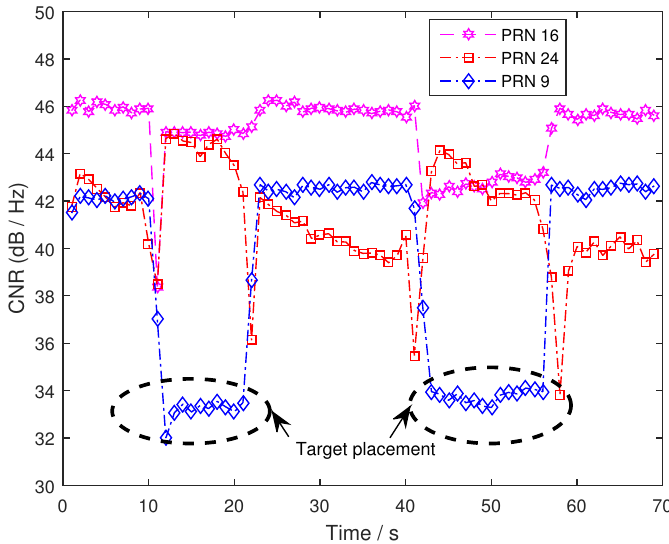
Figure 14. Carrier-to-noise ratio (CNR) information of the three BeiDou reflected